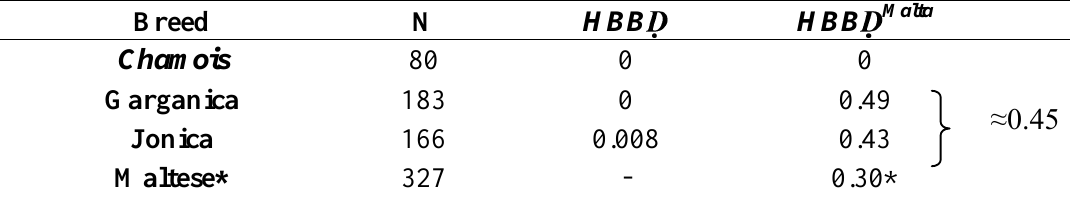
Table 7. Frequency of the positively charged variants at the HBB locus in Apulian native goat breeds compared to Chamois and Maltese breeds.